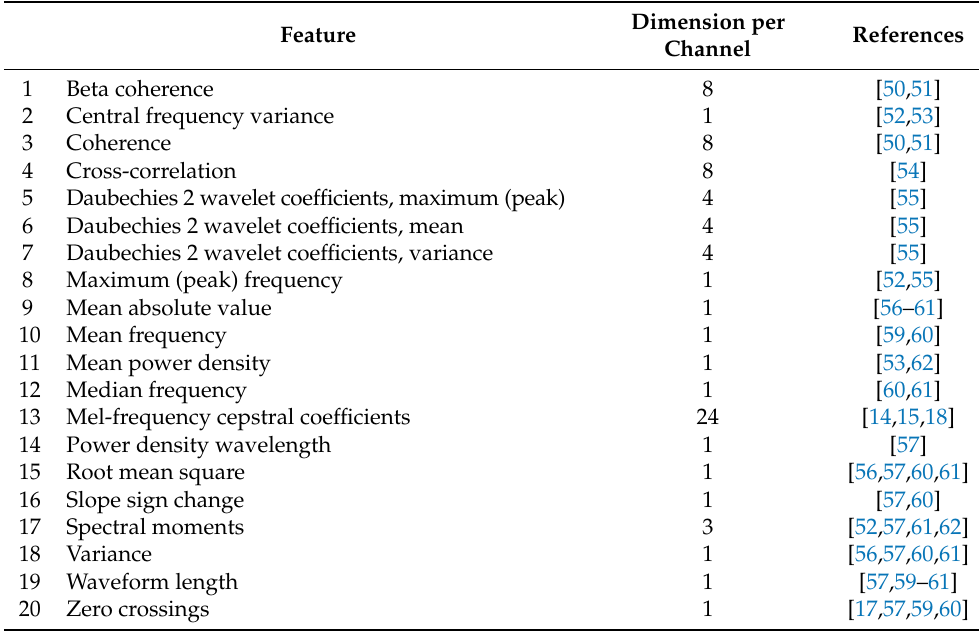
Table 2. Features used in sEMG data